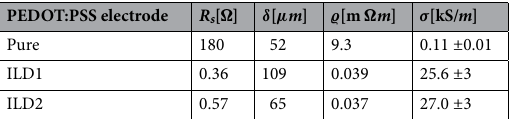
Table 1. Electric performance of pure and two ionic-liquid-doped (ILD) PEDOT:PSS electrodes.